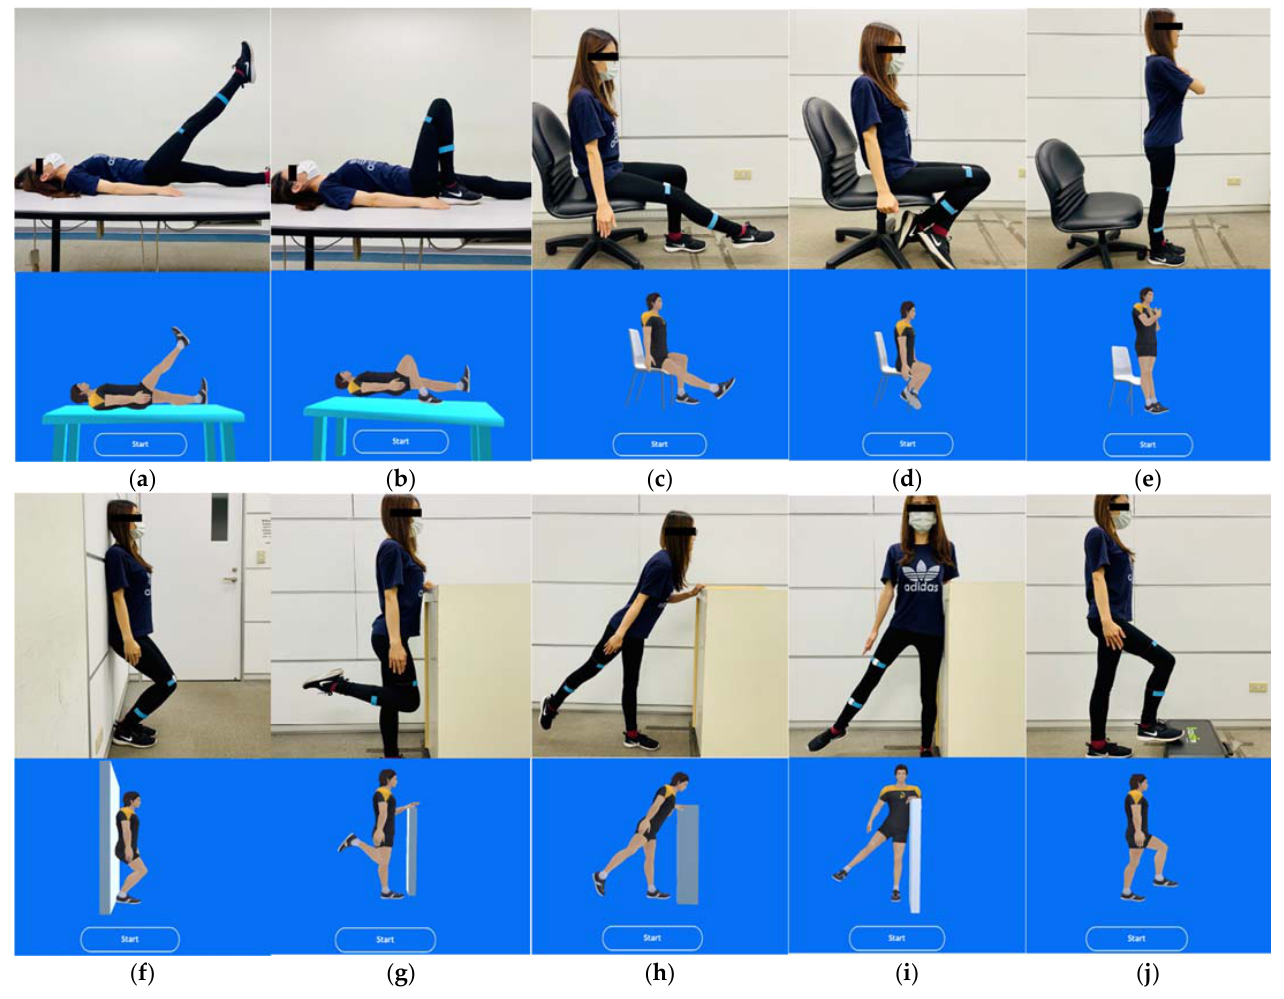
Figure 3. Sets of home-based knee exercises displayed on the mobile app and demonstrated by participants: ( a ) straight leg raise in bed; ( b ) knee flexion in bed; ( c ) sitting knee stretch; ( d ) sitting knee flexion; ( e ) sit-to-stand; ( f ) semi-squat on wall; ( g ) standing knee flexion; ( h ) standing hip extension; ( i ) standing hip abduction; ( j ) forward step-ups.